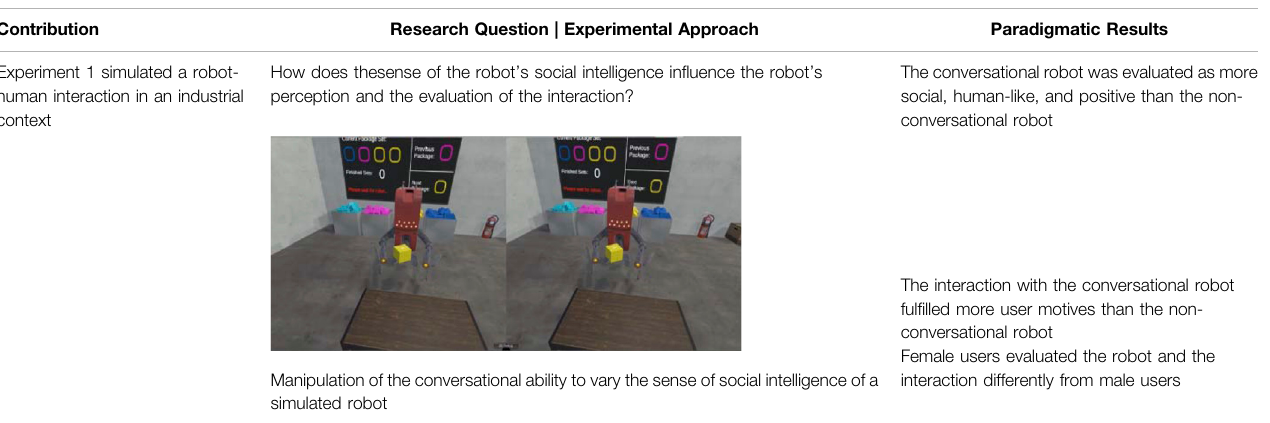
TABLE 7 | summarizes the results of the article ’ s second part.